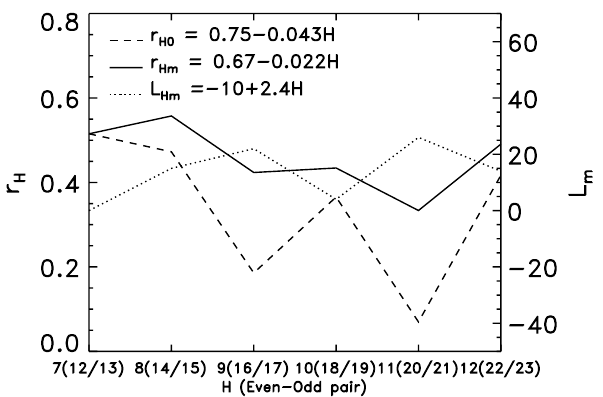
Fig. 4. Trends of r H0 (dashed), r Hm (solid) and L Hm (dotted) for Hale cycles of E-O cycle